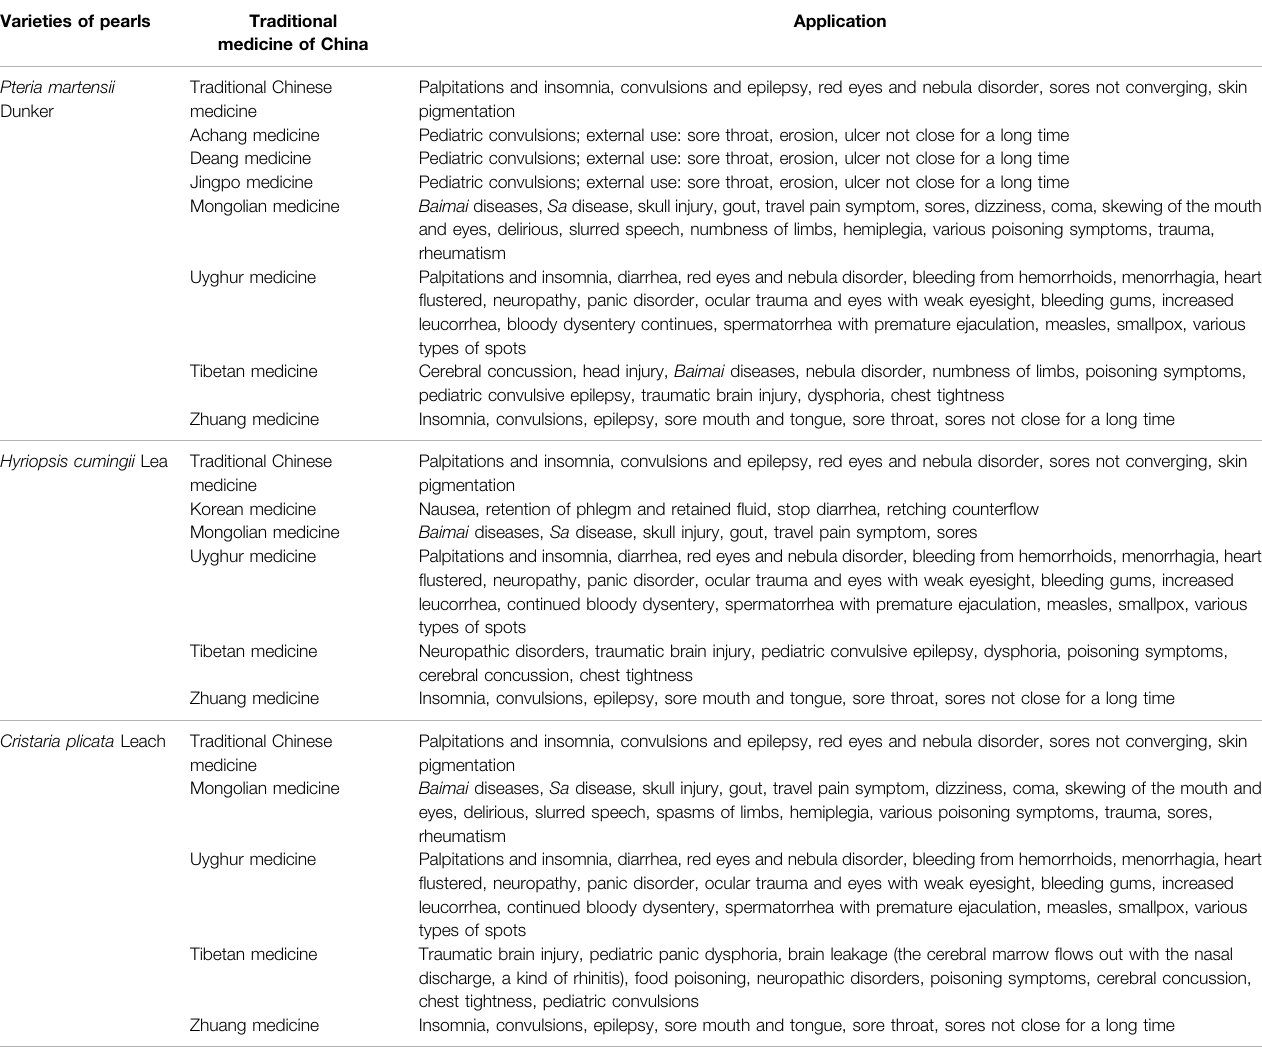
TABLE 2 | The application of pearls in the traditional medicine of China. Varieties of